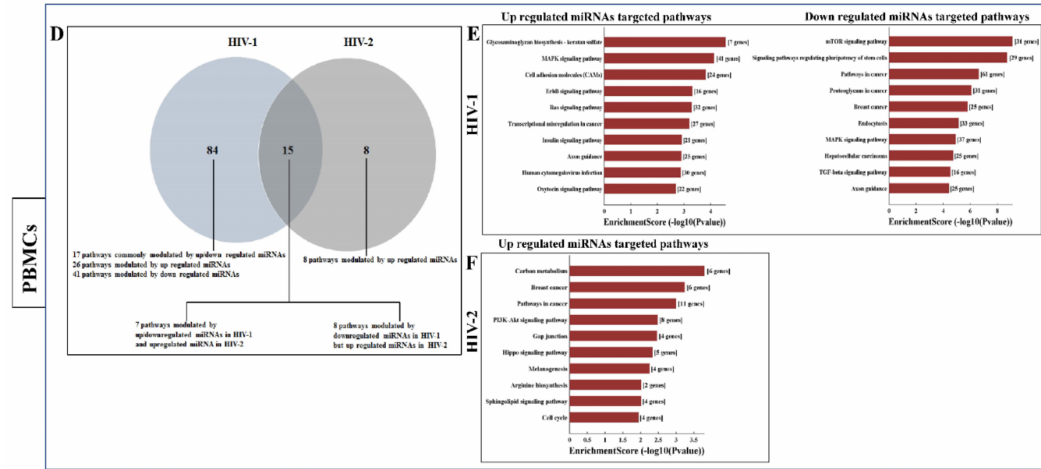
Figure 6. KEGG pathway analysis of di ff erentially expressed miRNA-targeted genes in MDMs and PBMCs infected with HIV-1 and HIV-2: ( A ) Venn diagram indicates the numbers of overlapping and non-overlapping di ff erentially regulated miRNA-targeted pathways in HIV-1 and HIV-2 infected MDMs. ( B , C ) The top ten KEGG pathways enriched in HIV-1 infected MDMs vs. uninfected controls ( B ) and HIV-2 infected MDMs vs. uninfected controls ( C ). The bar plot shows Fold Enrichment value of the significant enrichment terms and pathway analysis for di ff erentially expressed upregulated and downregulated miRNA-targeted genes in HIV-1 / HIV-2 infected MDMs, respectively. ( D ) Venn diagram indicates the numbers of overlapping and non-overlapping di ff erentially regulated miRNA-targeted pathways in HIV-1 and HIV-2 infected PBMCs. ( E , F ) The top ten KEGG pathways enriched in HIV-1 infected PBMCs vs. uninfected controls ( E ) and HIV-2 infected PBMCs vs. uninfected controls ( F ). The bar plot shows Fold Enrichment value of the significant enrichment terms and pathway analysis for di ff erentially expressed upregulated and downregulated miRNA-targeted genes in HIV-1 / HIV-2 infected PBMCs,